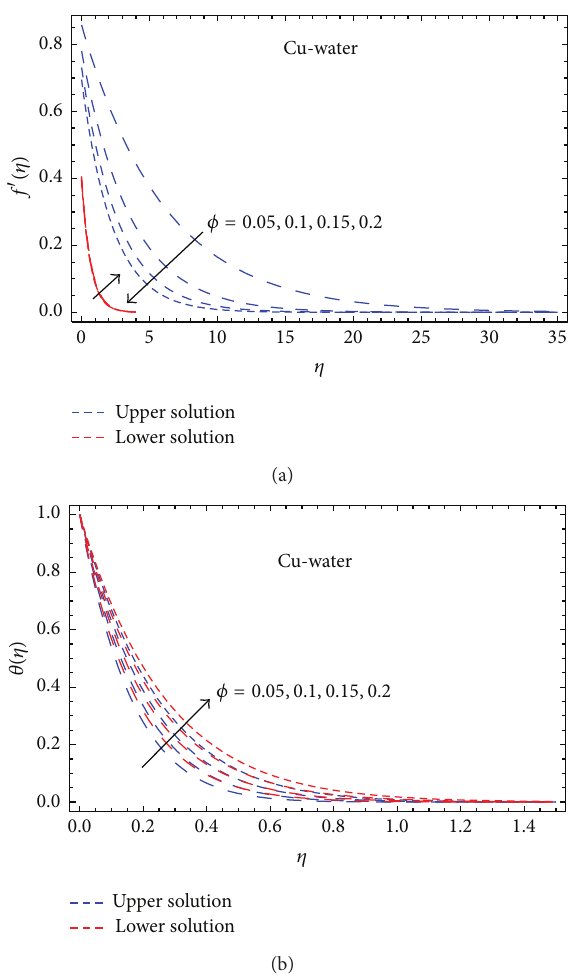
Figure 10: (a) Dual velocity for several values of 𝜙 at 𝑠 = 1 , 𝜆 = 1 , and 𝑀 = 1 . (b) Dual temperature for several values of 𝜙 at 𝑠 = 1 , 𝜆 = 1 , and 𝑀 = 1